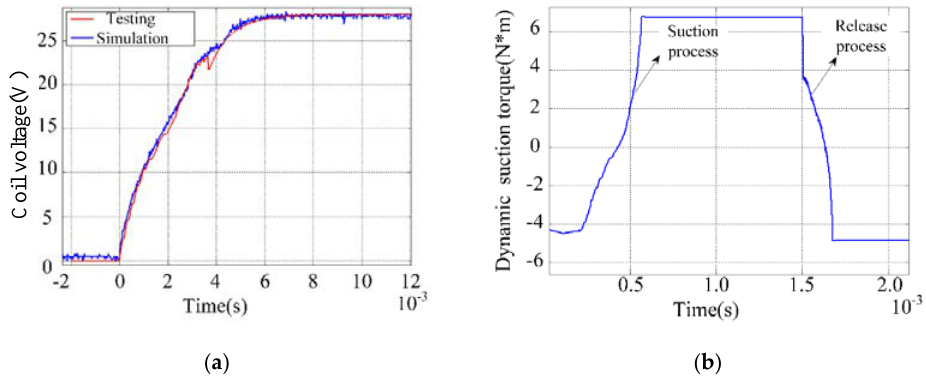
Figure 11. The simulation results of the rotary PMA: ( a ) coil voltage; ( b ) dynamic suction and release output characteristics.